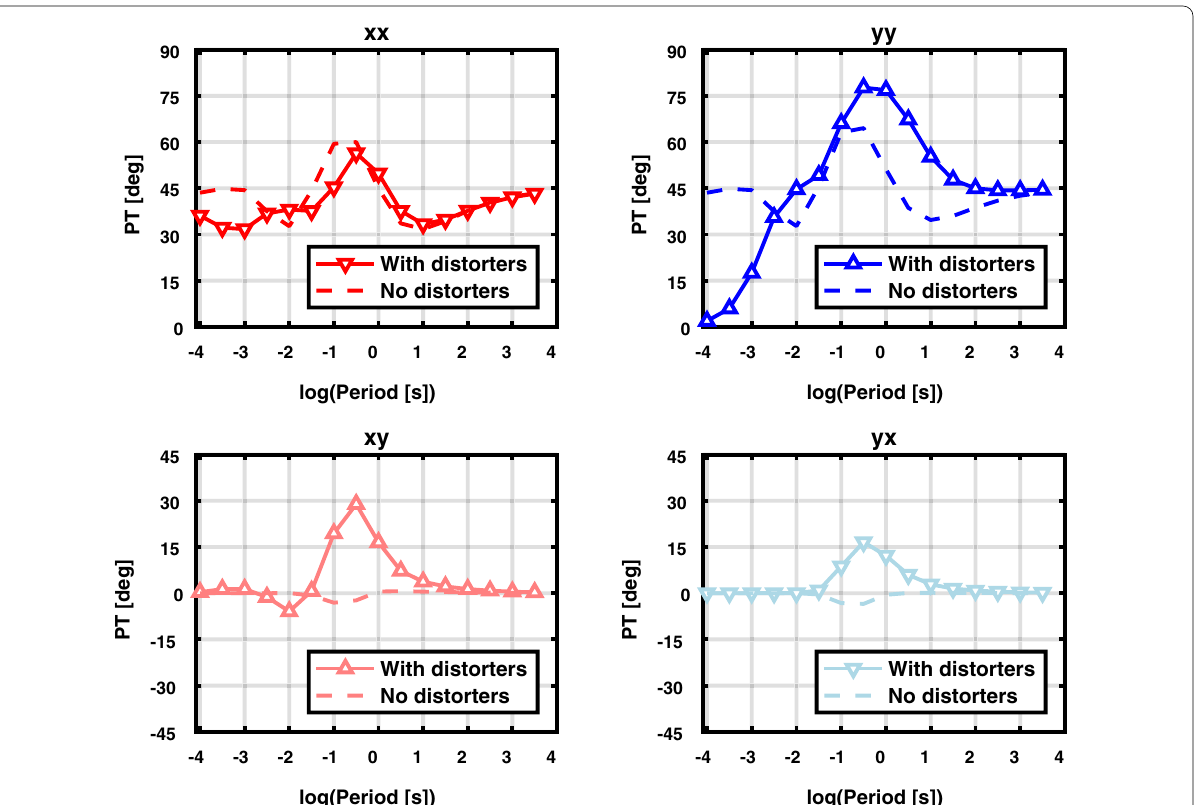
Fig. 22 Period dependence of PT in arctangent scaling (solid curves with symbols) from a strongly distorted station (syn‑0505) in the oblong distorter model and those from the model without distorters (dashed